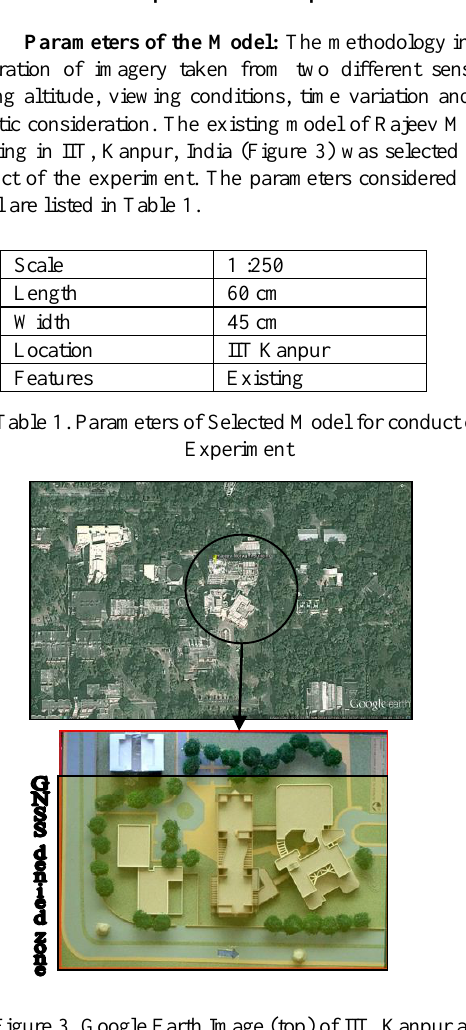
Figure 3. Google Earth Image (top) of IIT, Kanpur and the model of Rajeev Motwani Building selected (bottom) for conduct of